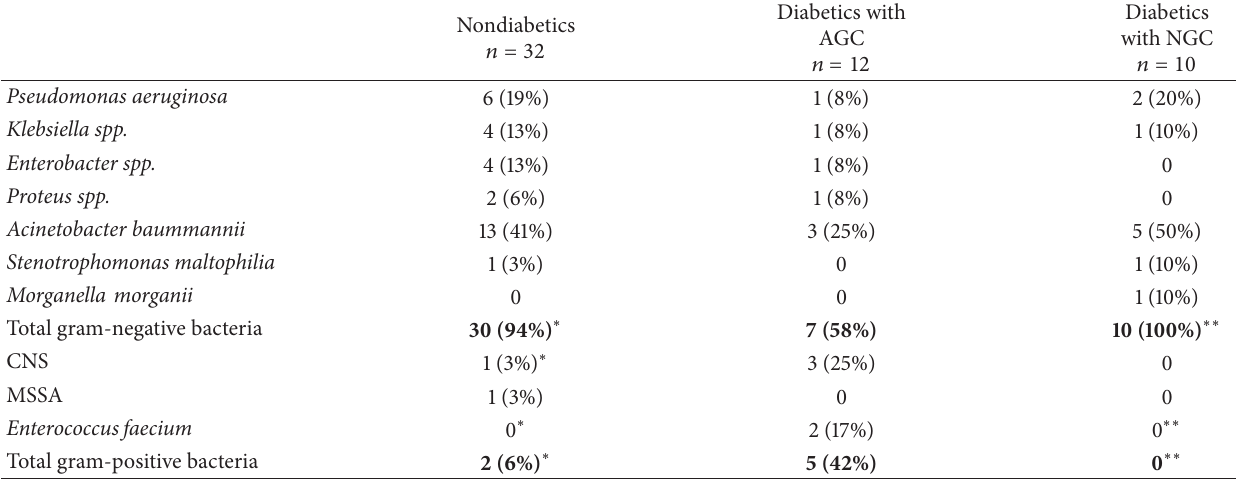
Total gram-negative bacteria MSSA 1 (3%) 0 0 Enterococcusfaecium 0 ∗ 2 (17%) Total gram-positive